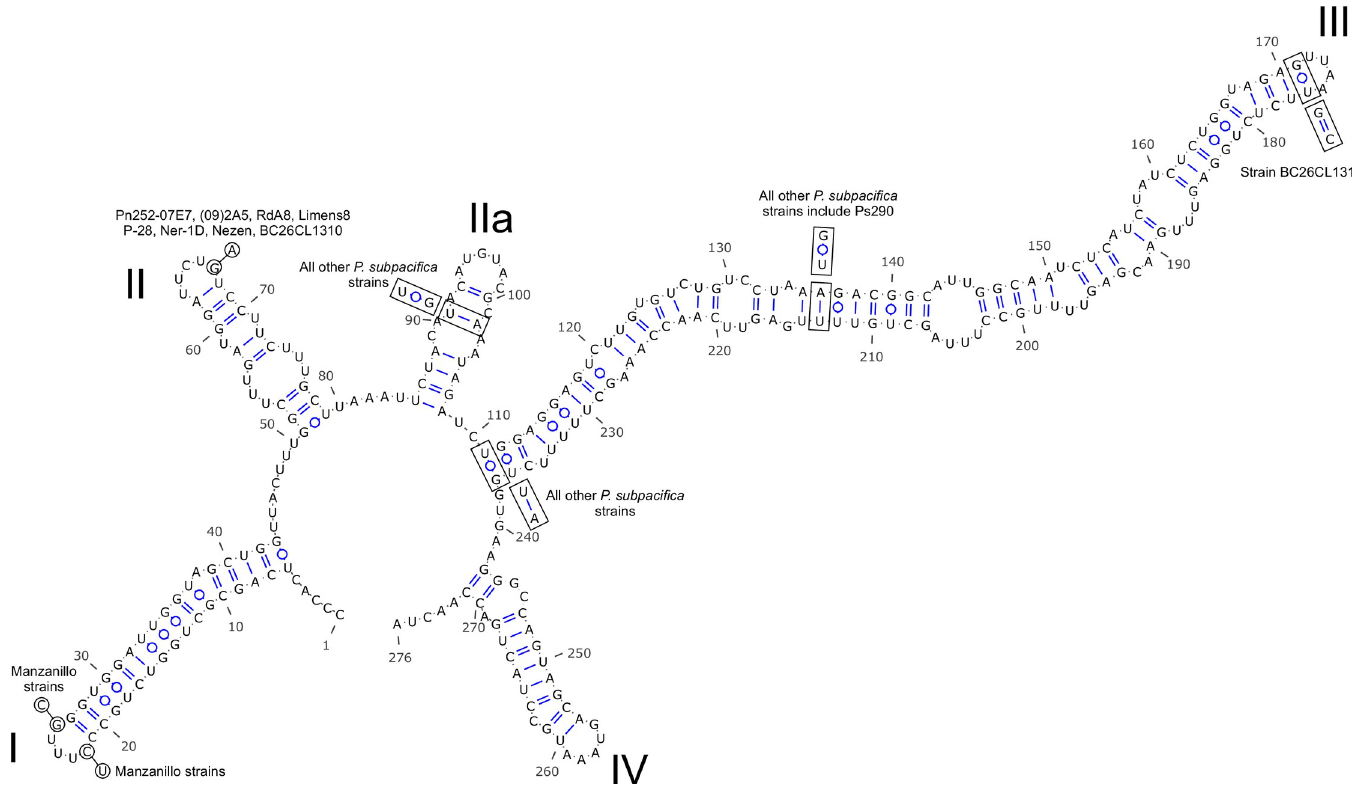
Fig 3. Secondary structure of Pseudo-nitzschia subpacifica strain Ps291 (Todos Santos Bay) ITS2, with comparisons to other P . subpacifica strains.